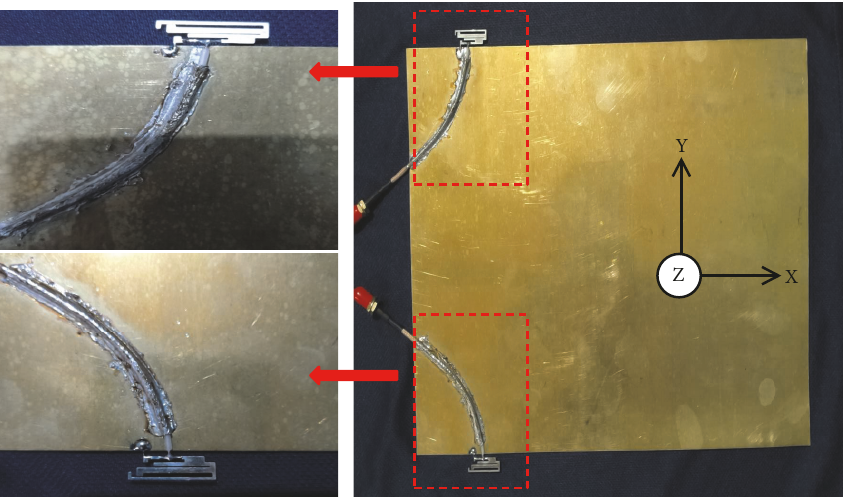
Figure 11: Fabricated photo of proposed MIMO antenna for laptop computers.